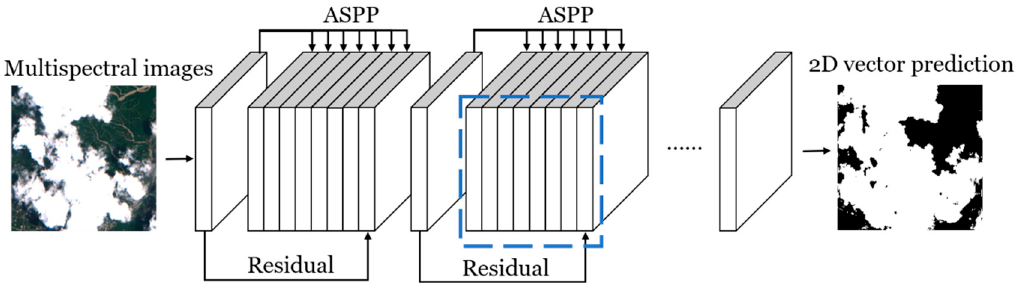
Figure 7. Illustration of the CloudNet architecture for cloud classification.